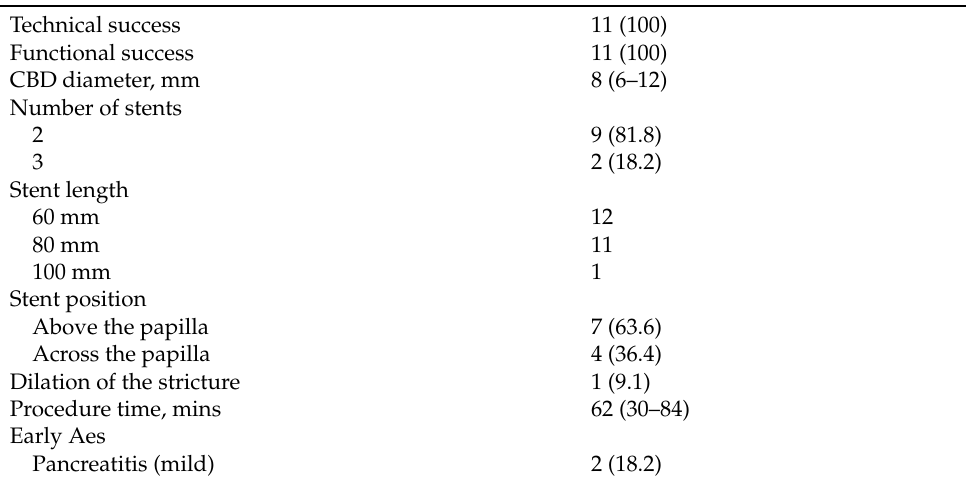
Table 2. Procedure details and